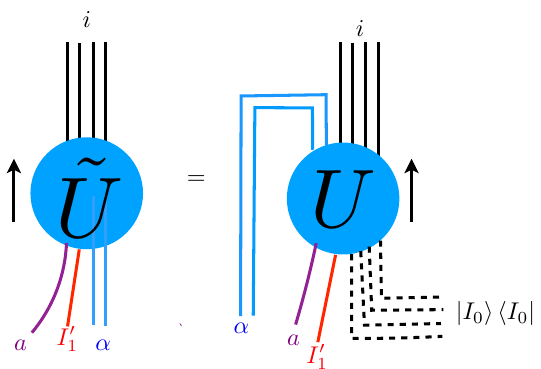
Figure 2 . Operator ˜ U involves side-way evolution of operator U